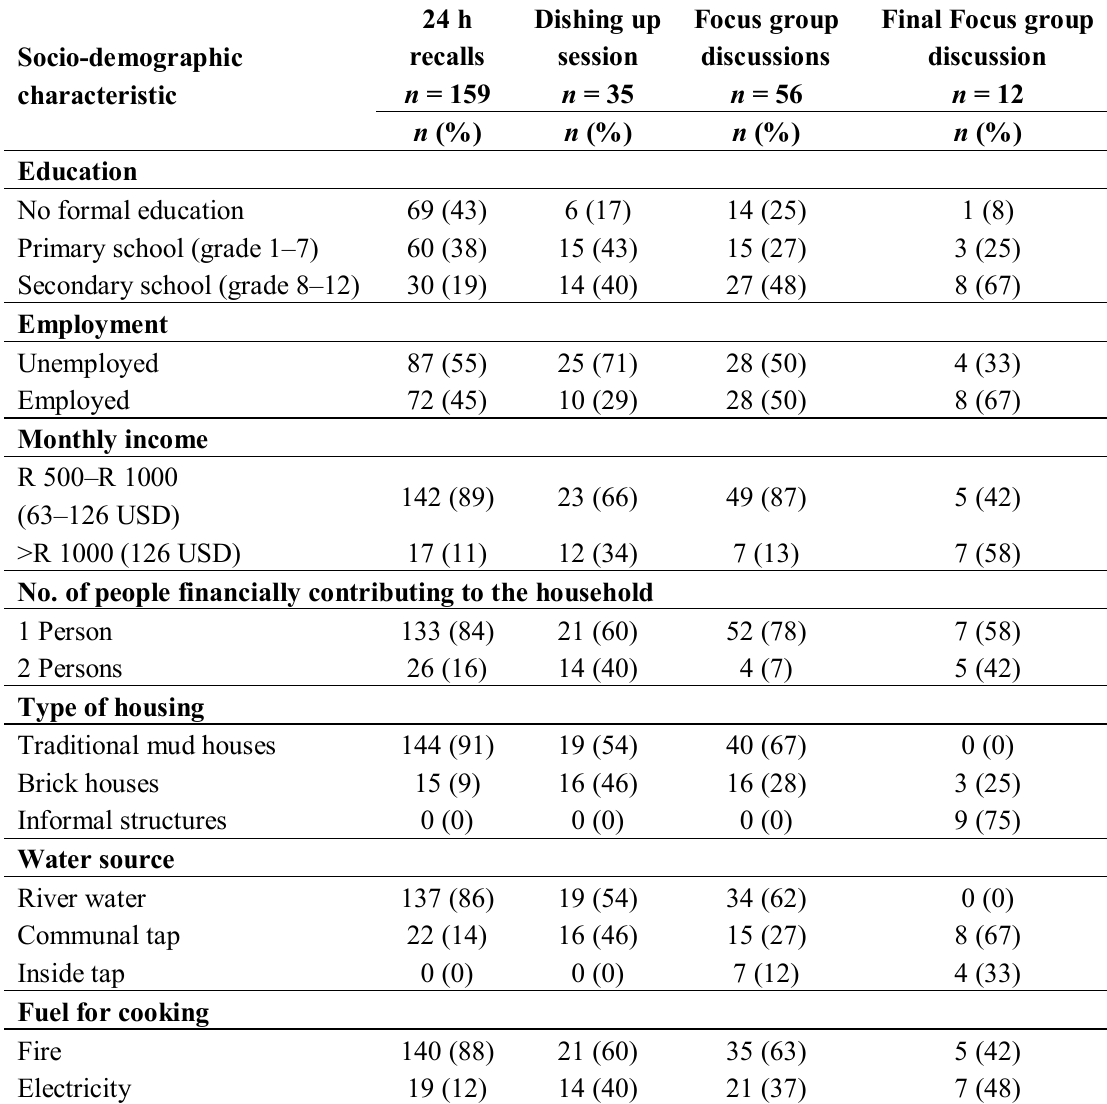
Table 2. Socio-demographic description of